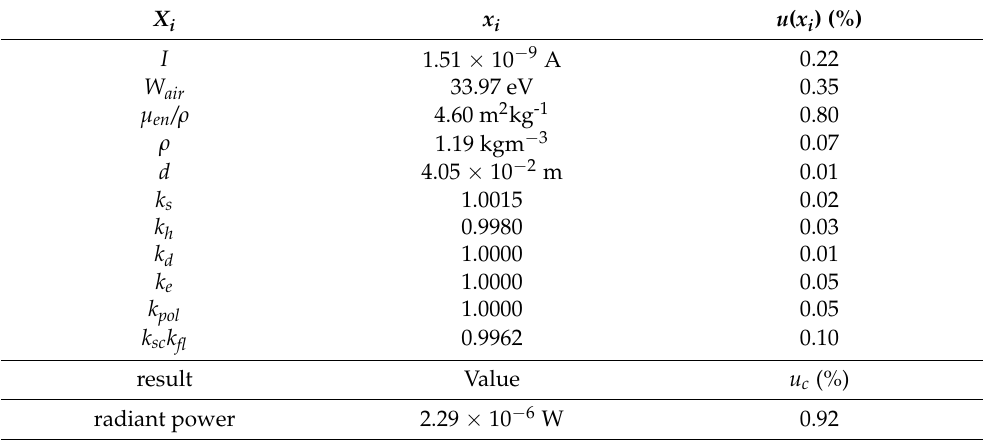
Table 1. Contributions to the relative standard uncertainty of radiant power P ( k = 1) for mea- surement with the FAC at photon energy of 10 keV. The term k is the coverage factor for the expanded